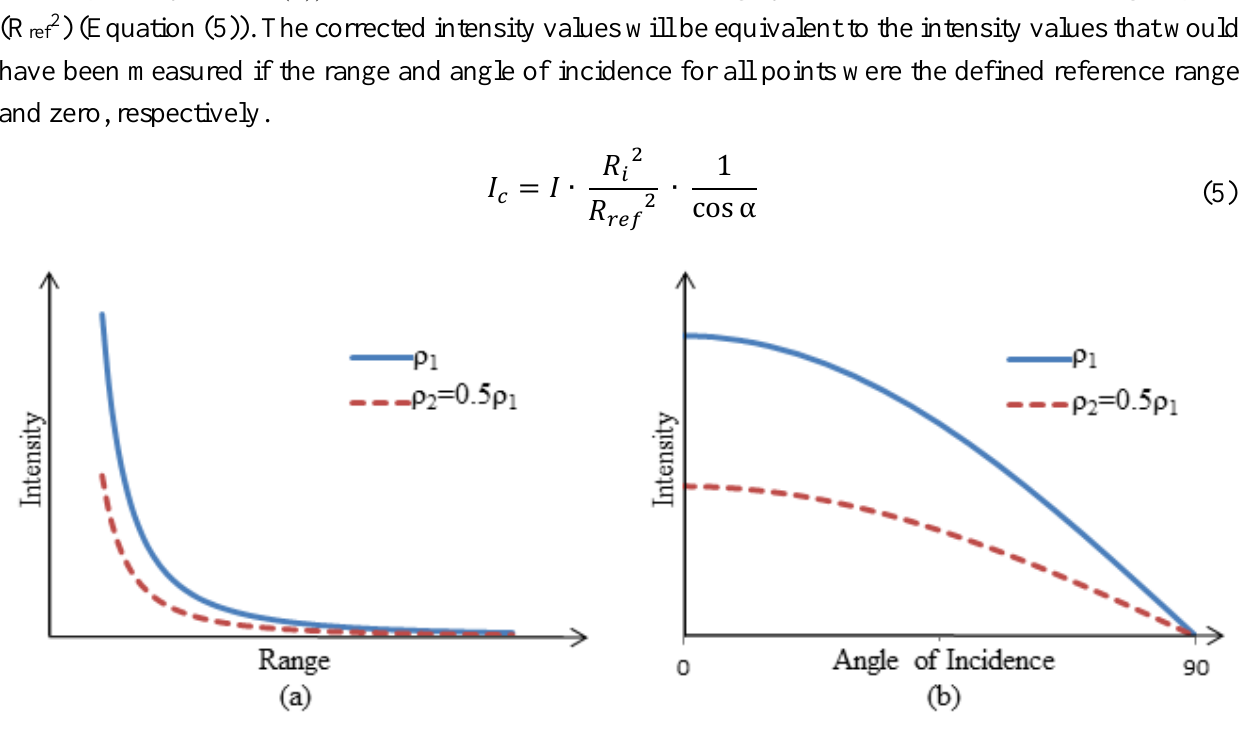
Figure 6. ( a ) Theoretical relationship of intensity measurements vs . range shown for two materials with different reflectance (ρ); and ( b ) theoretical relationship of intensity measurements vs. angle of incidence shown for two materials with different reflectance